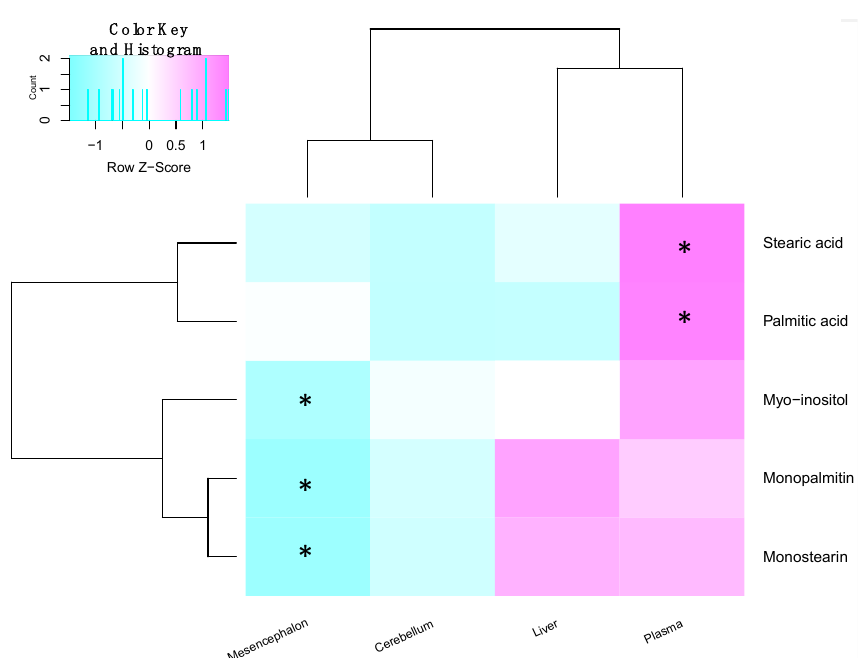
Figure 4. Heat map showing the fold change of metabolites between the sham and 6-OHDA groups within the different tissues. Similarly changed metabolites are clustered together, while tissues with similar changes in metabolites are near to each other. Significantly changed metabolites between the sham and 6-OHDA treated rats are marked for each tissue. (* indicates p < 0.05 after Benjamini–Hochberg correction, in that tissue.